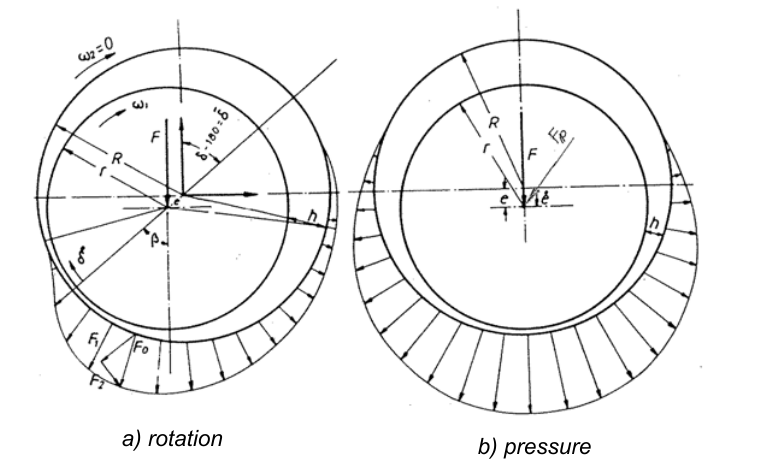
Figure 3 – Display of a radial bearing with dynamic load forces Рисунок 3 – Отображение радиального подшипника с динамическими нагрузками Слика 3 – Приказ радијалног лежаја са динамичким силама